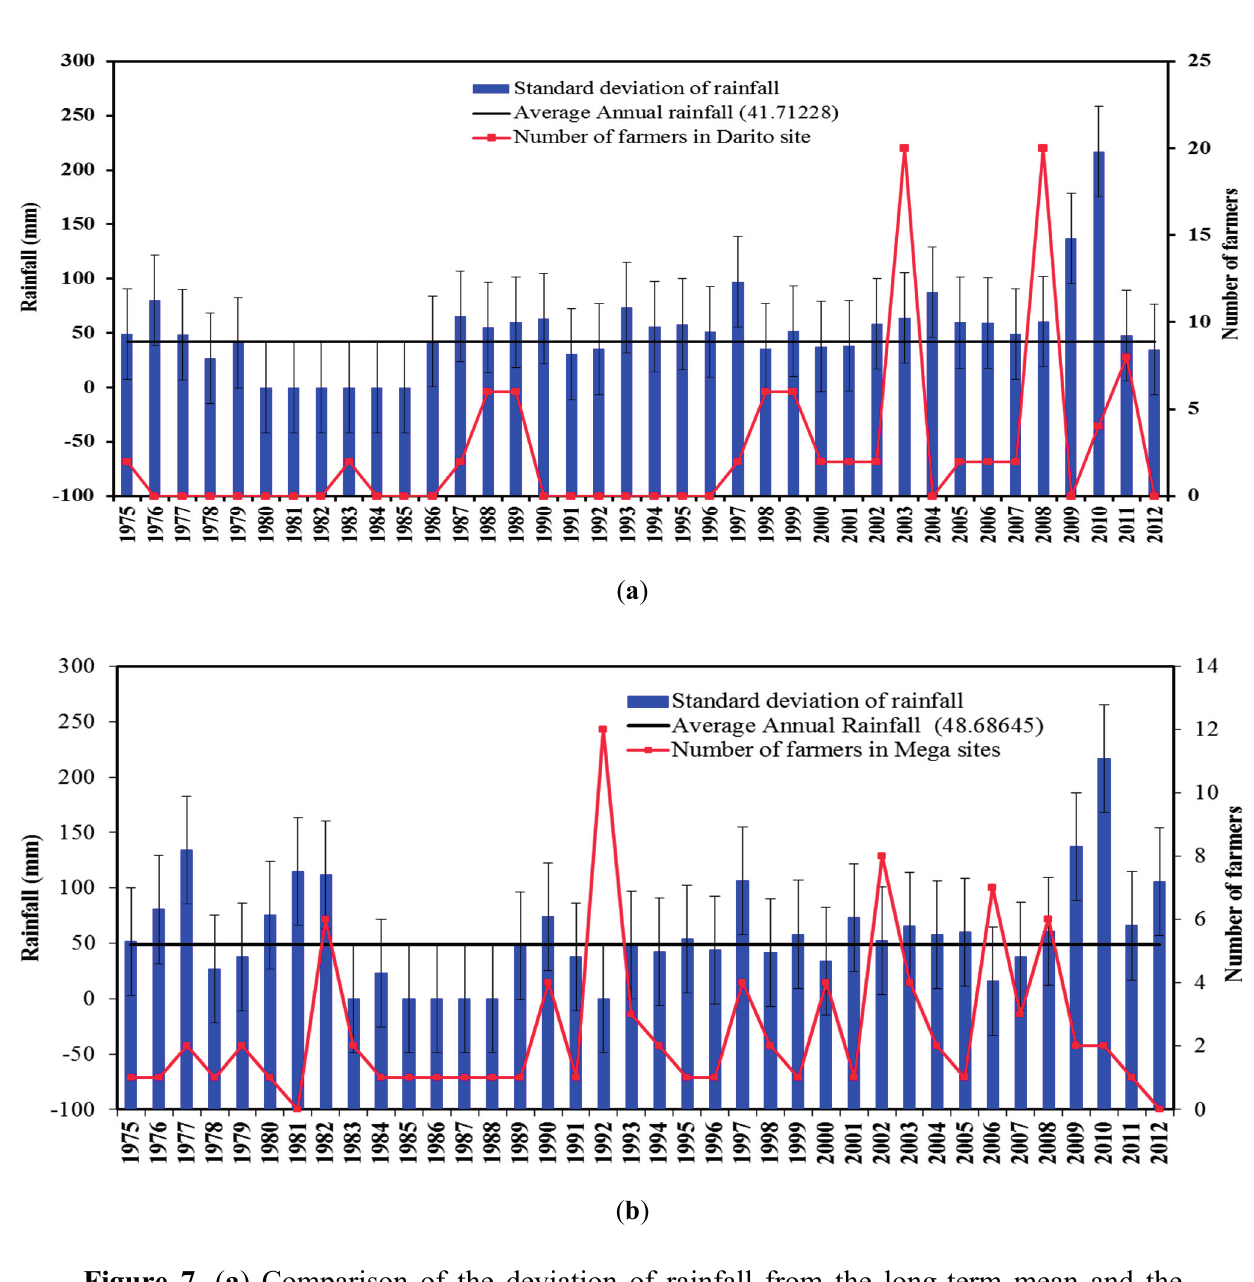
Figure 7. ( a ) Comparison of the deviation of rainfall from the long-term mean and the number of those engaging in crop farming in Darito: Source: Ethiopian Meteorological Agency 2012; ( b ) Comparison of the deviation of rainfall from the long-term mean and the number of farmers in the Mega sites: Source: Ethiopian Meteorological Agency